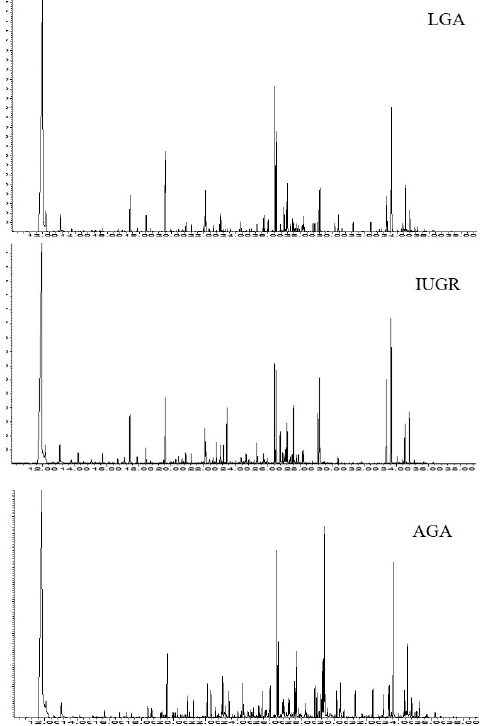
Figure 1. Gas-chromatography mass spectrometry (GC-MS) chromatograms of urine samples collected at the first day of life.